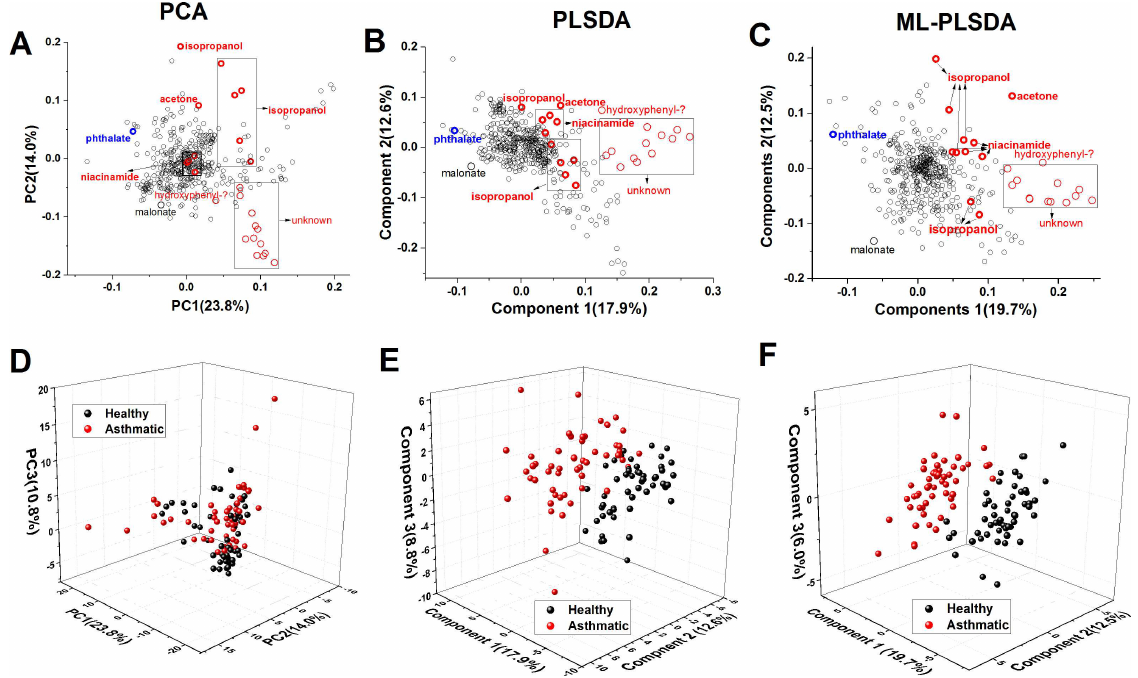
Fig 1. Comparison of loading and score plots generated from preprocessed NMR spectra of EBC from 53 cats before (black) and after induction of early allergic asthma (red), using multivariate statistics. Panels A and D show PCA results. Panels B and E plot PLS-DA results. Panels C and F report multi-level PLS-DA results. Components 1 and 2 are plotted in the loadingplots (A–C). Components 1, 2, and 3 are plotted in the score plots (D–F). Biomarkers that increasedin the experimental asthma are labeledin red. A marker that decreasedin the experimental asthma is labeledin blue. A peak too weak to be useful is labeledin gray. Efforts to identify the markers are